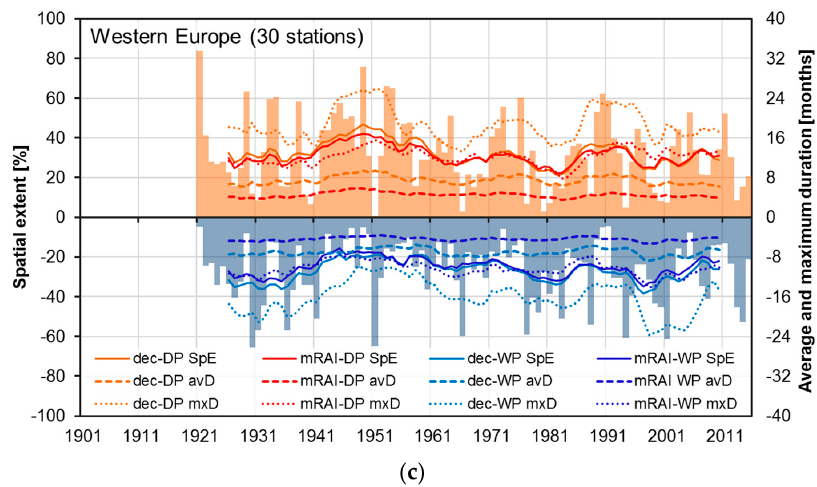
Figure A4. Time series (annual resolution; 11-year low pass filtered data) of spatial extent (SpE; bars for decile index) as well as average (avD) and maximum duration (mxD) of dry (DP) and wet periods (WP) as indicated by the deciles index (dec; orange and light blue) and the mRAI (red and intense blue) for the sub-regions ( a ) EE, ( b ) CE, and ( c ) WE for period 1901–2015. For illustration purposes, the WP results are printed as negative values.